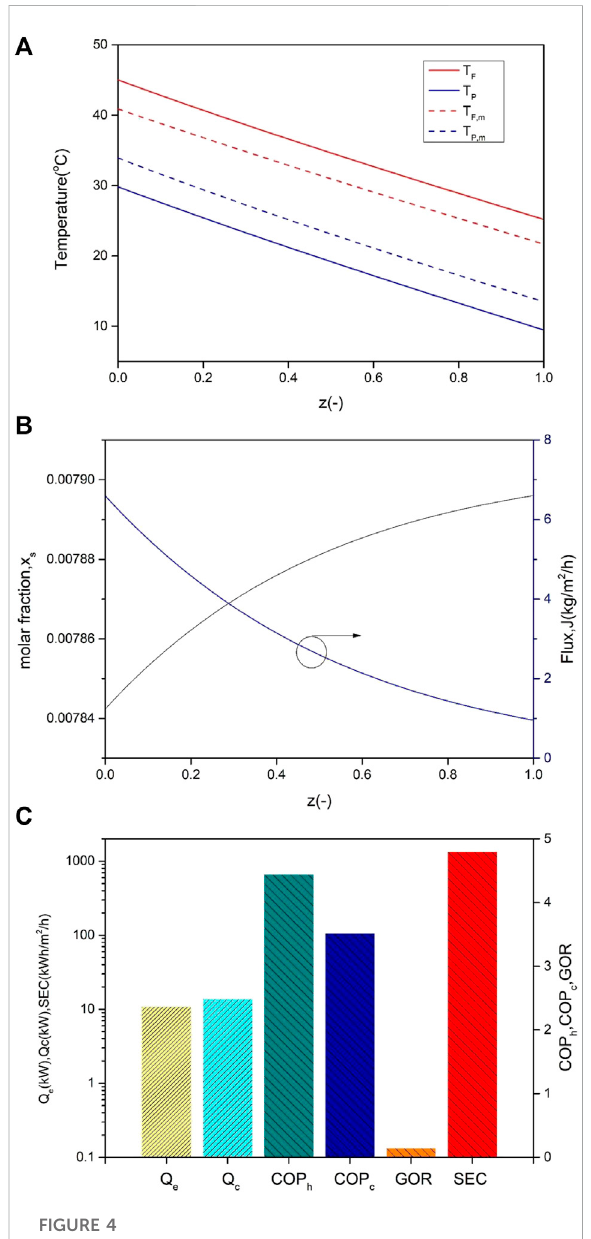
FIGURE 4 Simulation results of HP-DCMD on baseline condition (T F,in = 45 ° C,T p,in = 10 ° C, V F,in = 10 lpm, V P,in = 10 lpm, and rpm = 2000): (A) temperature variations as a function of normalized module length, (B) molar fraction of non-volatile component and the local permeate fl ux, and (C) performance indices of